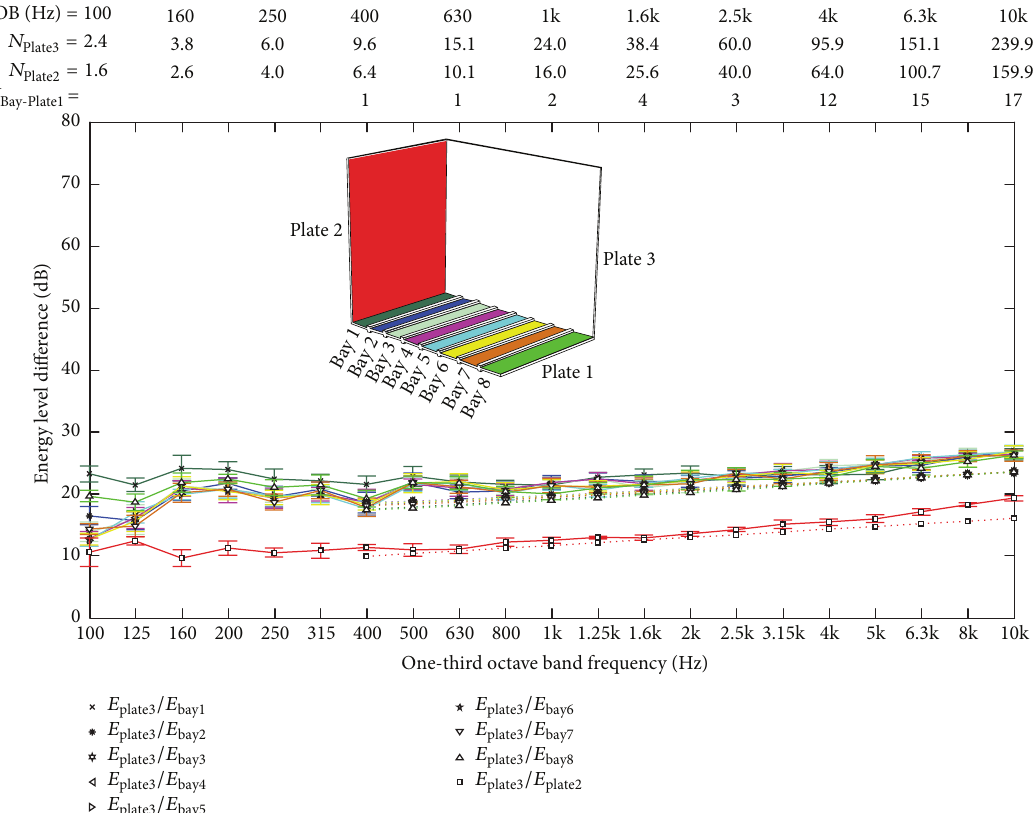
Figure 14: Three coupled plates. Excitation: Plate 3. Energy level differences between the isotropic plate (Plate 3) and each of the bays that form the other periodic ribbed plate (Plate 1) as well as the other isotropic plate (Plate 2). Comparison between FEM and ASEA (FEM data are shown using markers with continuous lines; ASEA data are shown using markers with dotted